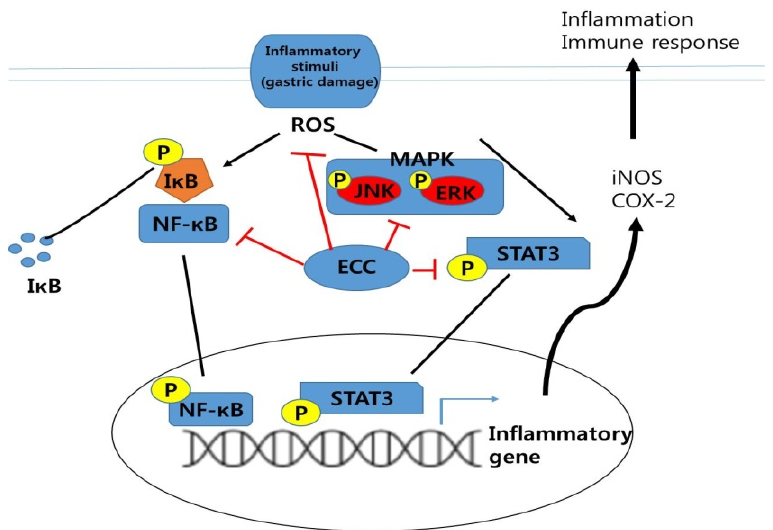
Figure 11. Schematic illustration of the mechanism of ECC against inflammation (gastric damage).